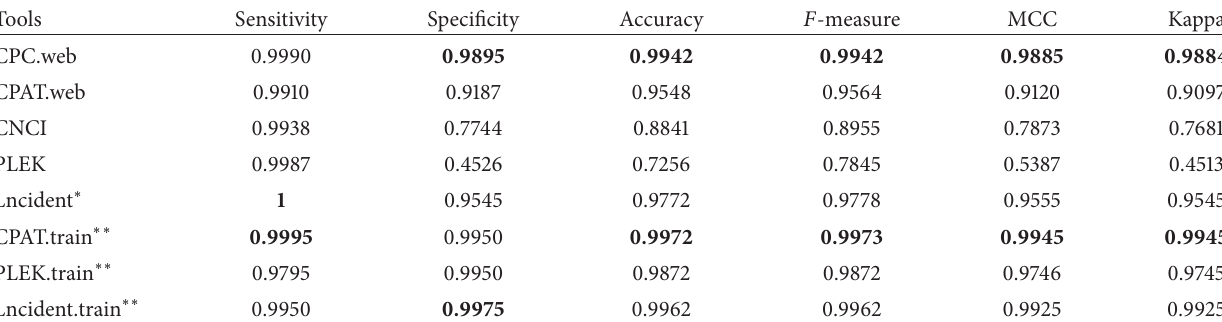
Table 2: Comparisons of C. elegans .